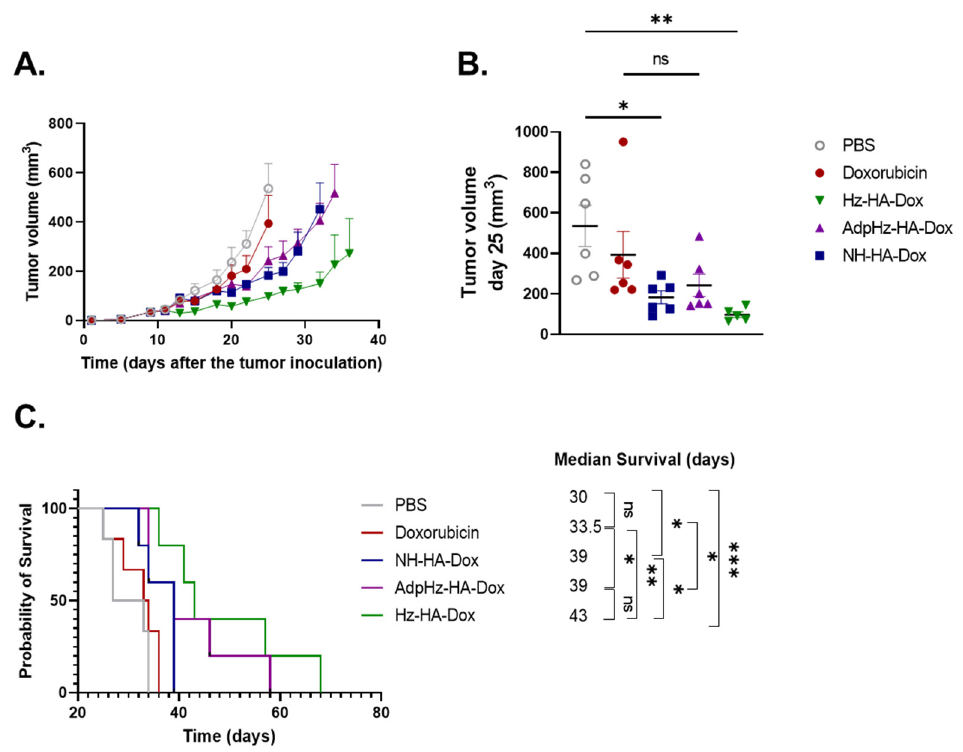
Figure 5. Anti-tumor effect on GL261 tumor-bearing mice model treated with DOX and HA-DOX. ( A ) C57BL/6J mice were treated with PBS, DOX, HA-NH-DOX, HA-Hz-DOX, and HA-AdpHz-DOX conjugates (3 mg/kg in DOX equivalent) after 10 days following tumor transplantation. Tumor growth was delayed in the HA-Hz-DOX group (green); in the PBS (grey) and the DOX (red) groups, the tumor growth was higher in comparison to the groups treated with the HA-DOX conjugates; in the HA-NH-DOX (blue) and the HA-AdpHz-DOX (violet) groups, the tumor growth rate was overlapped. Each point represents the mean of tumor size. ( B ) Comparison of tumor distribution at day 25, indicating that HA-Hz-DOX was statistically significant compared to untreated and DOX. ( C ) Kaplan–Meier curves: HA-Hz-DOX and HA-AdpHz-DOX groups presented the highest survival rate. (Mean, error bar = SEM, N = 5, statistical analysis obtained by one-way ANOVA multiple comparison: ns = not significant, * p < 0.05, ** p < 0.01, *** p <